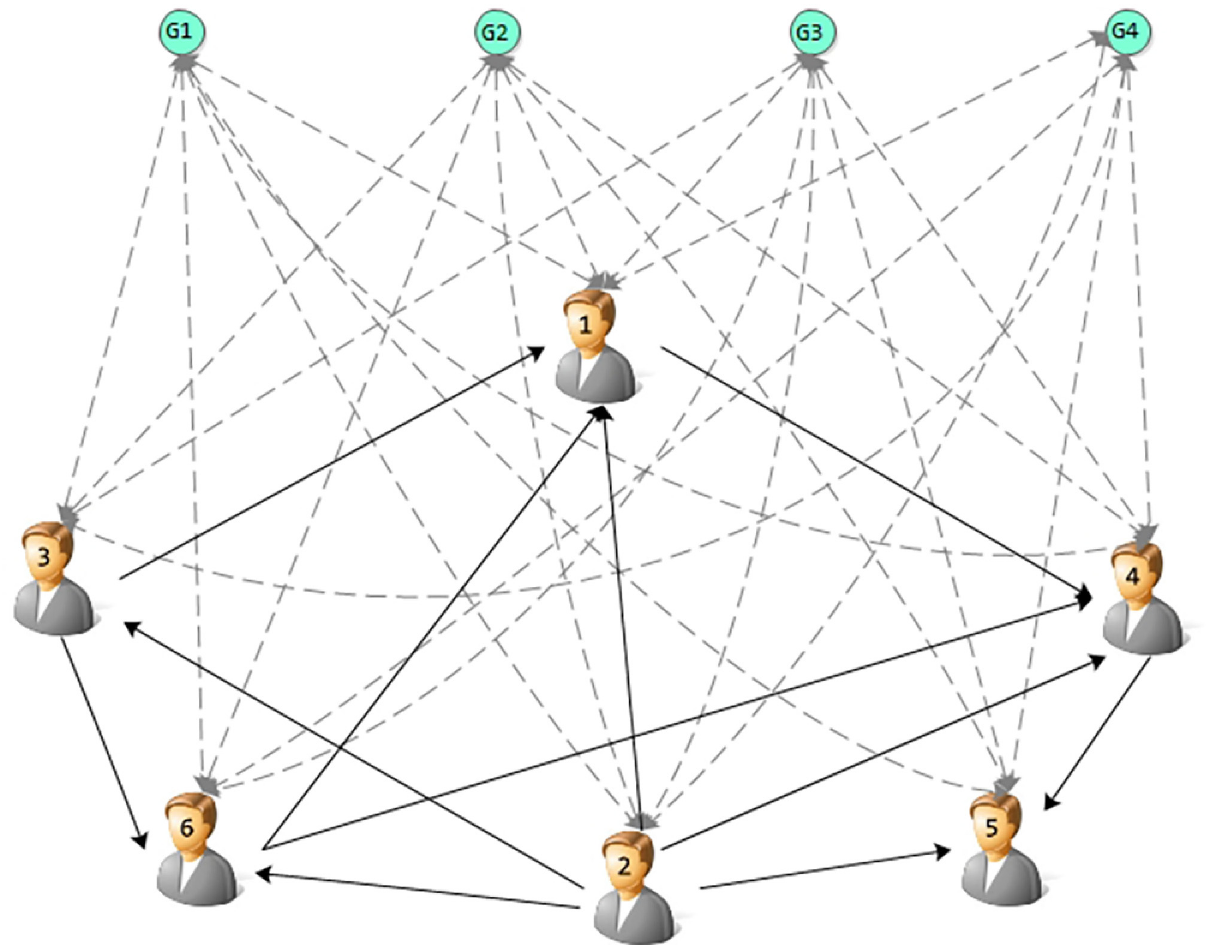
Fig 2. An illustration of the ground nodes. There are four ground nodes in this network representing four topics.